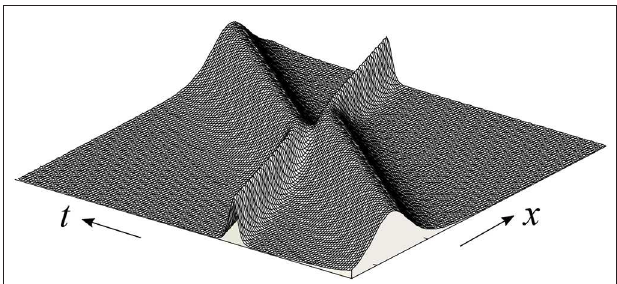
FIGURE 1 | Two soliton solution of KdV equation ( α momentum and shape are exactly conserved, time delay appears due to the collision (around ( t , x ) =